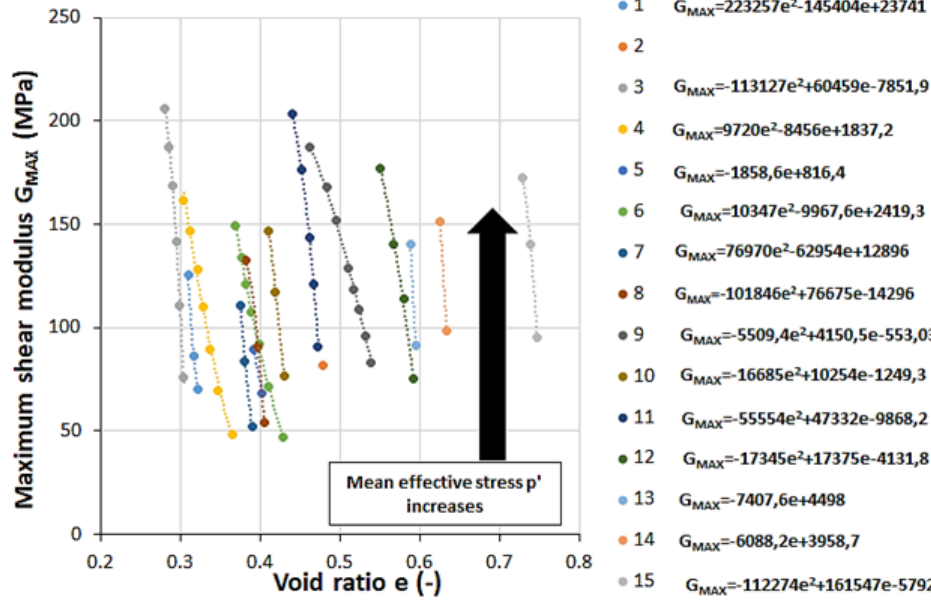
Figure 3. Maximum shear modulus (G MAX ) against void ratio (e).